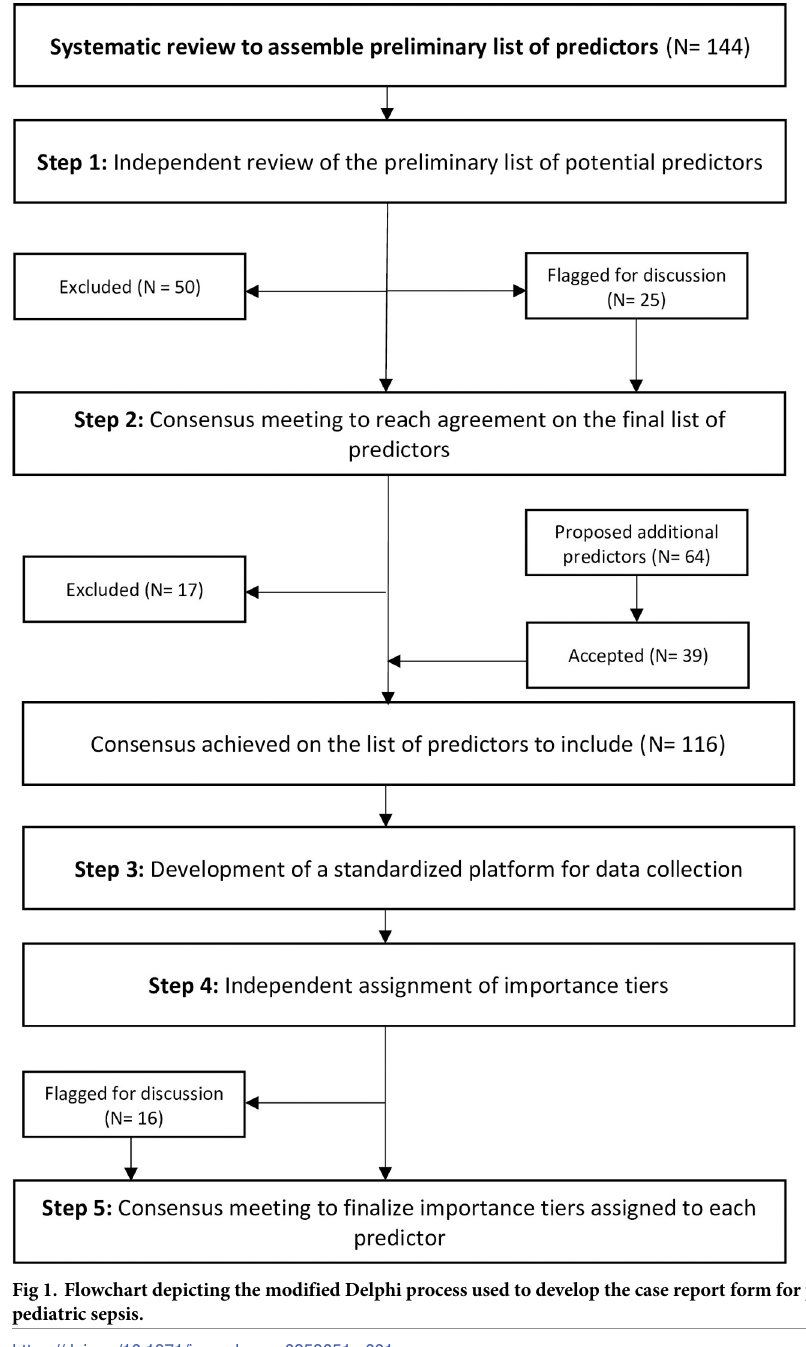
Fig 1. Flowchart depicting the modified Delphi process used to develop the case report form for predictors of pediatric sepsis.